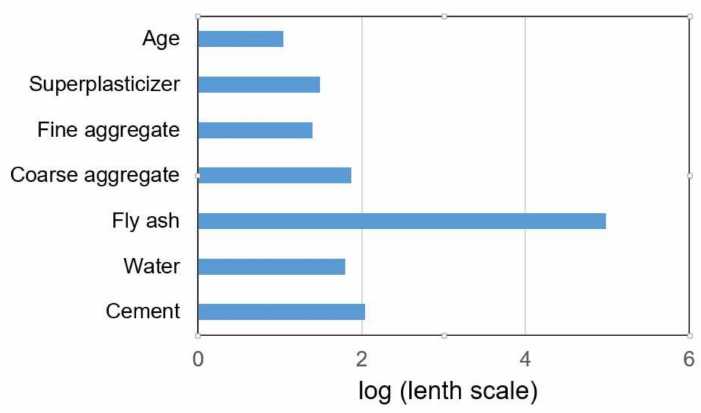
Figure 17. Variable importance using optimal ARD exponential covariance function.